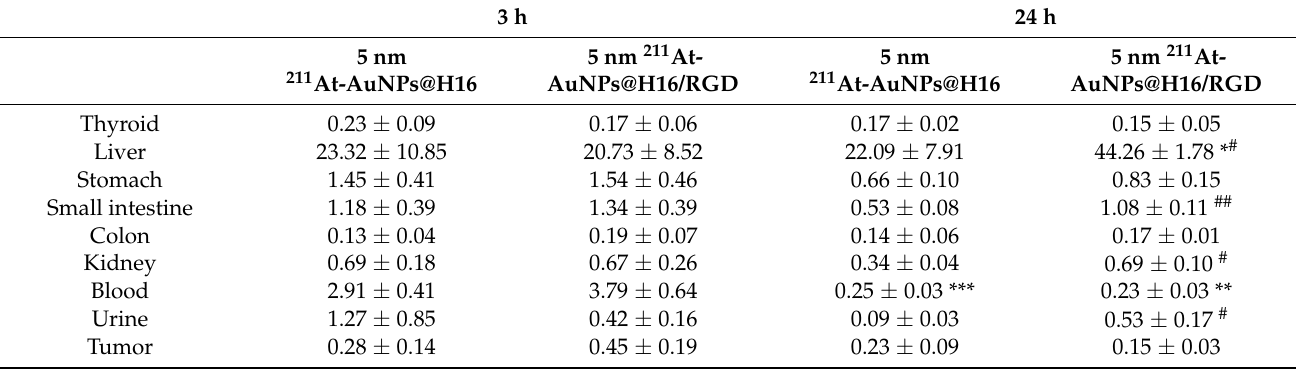
* Mean ± standard error (SE) of % ID/g is shown in the table. Significantly difference between 3 and 24 h is indicated as * p < 0.05 and ** p < 0.01, and between 5 nm 211 At-AuNPs@H16 and 5 nm 211 At-AuNPs@H16/RGD in 24 h as # p < 0.05, and ### p < 0.001. Table 4. Comparison of percentage distribution of injected dose (% ID) of 5 nm and 30 nm 211 At-